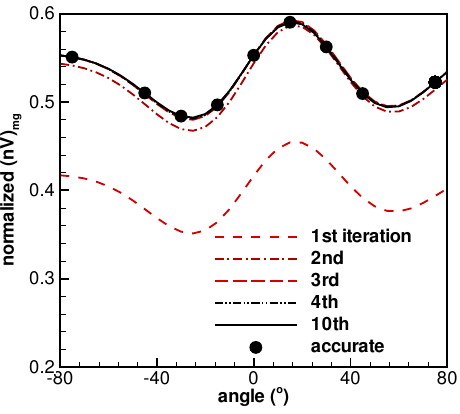
√ 2 RT 0 ) profile development history, along R = 3